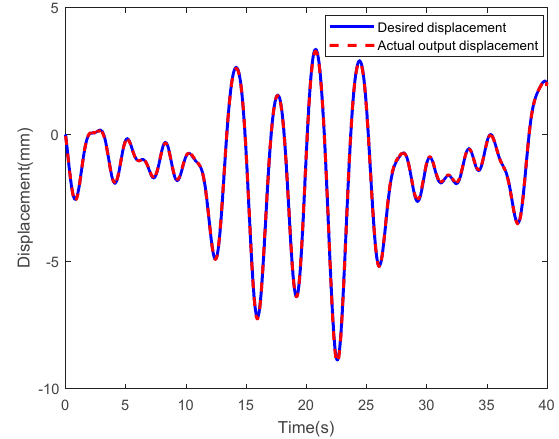
Figure 49. Control results at random sine input displacement. Figure 50. Control results at random sine input